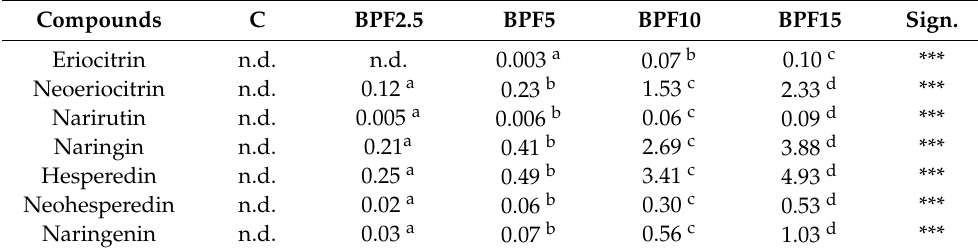
Table 7. Concentration values of Individual Flavonoids (IF, mg g − 1 ) in Biscuits. Compounds C BPF2.5 BPF5 BPF10 BPF15 Sign. Eriocitrin n.d. n.d. 0.003 a 0.07 b 0.10 c *** Neoeriocitrin n.d. 0.12 a 0.23 b 1.53 c 2.33 d *** Narirutin n.d. 0.005 a 0.006 b 0.06 c 0.09 d *** Naringin n.d. 0.21 a 0.41 b 2.69 c 3.88 d *** Hesperedin n.d. 0.25 a 0.49 b 3.41 c 4.93 d *** Neohesperedin n.d. 0.02 a 0.06 b 0.30 c 0.53 d *** Naringenin n.d. 0.03 a 0.07 b 0.56 c 1.03 d